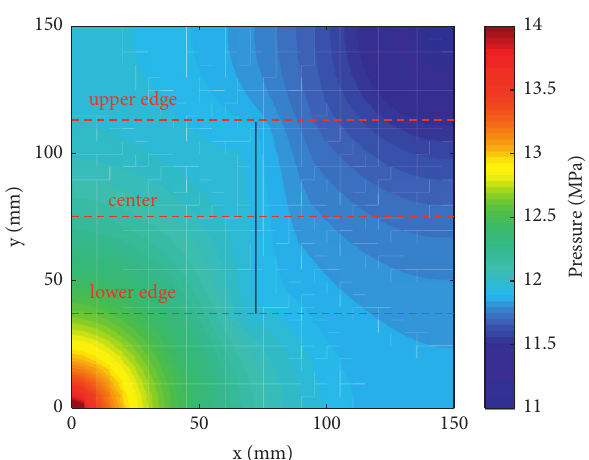
Figure 17: Oil pressure distribution of the fine grid simulation after 1800seconds of injection.